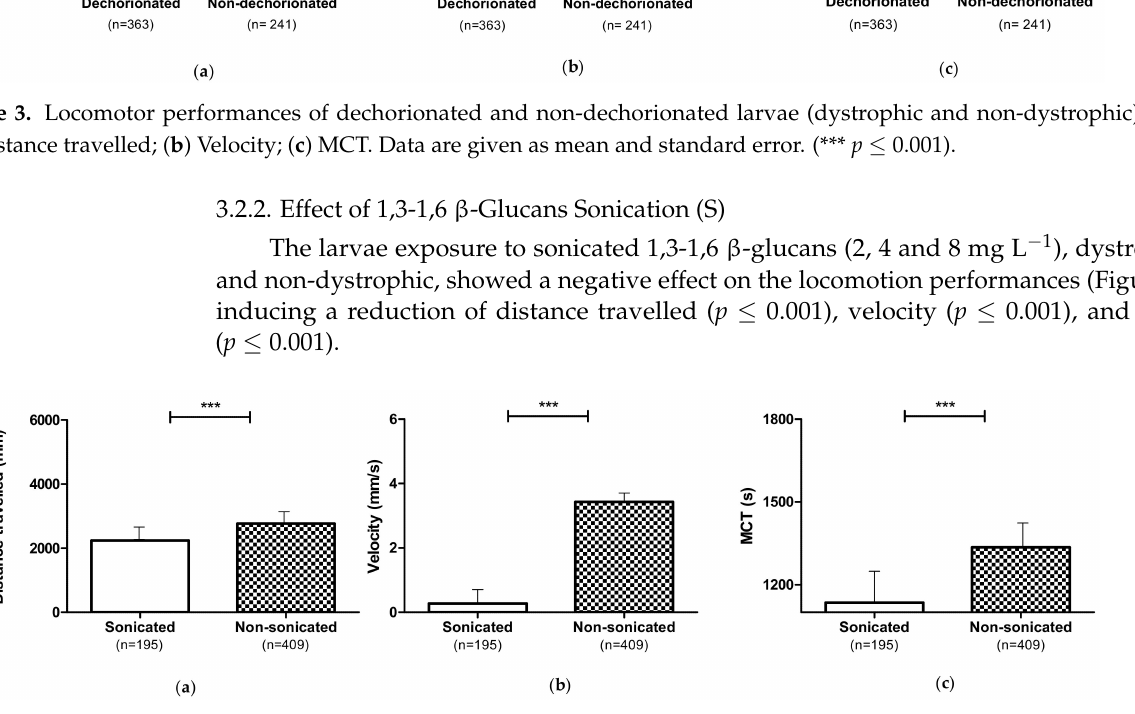
Figure 4. Locomotor performances of larvae (dystrophic and non-dystrophic) treated with non-sonicated or sonicated 1,3-1,6 β -glucans at 2, 4, and 8 mg L − 1 : ( a ) Distance travelled; ( b ) Velocity; ( c ) MCT. Data are given as mean and standard error. (*** p ≤